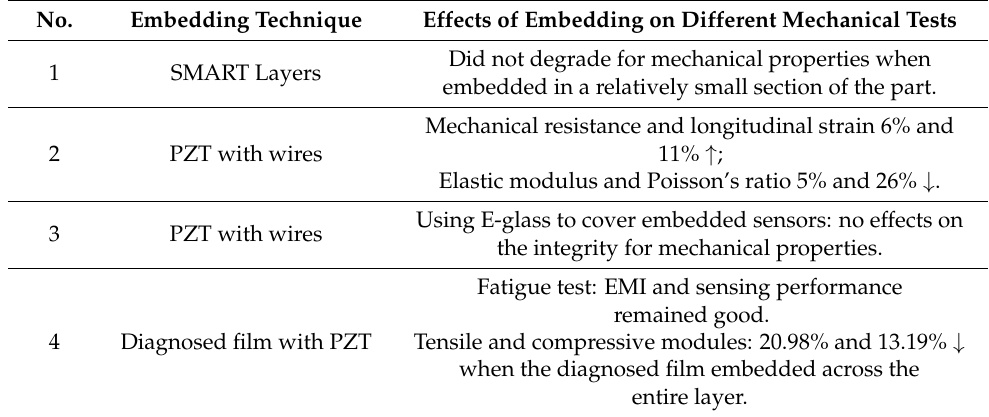
Table 1. Summary of effects of embedded PZT transducers on mechanical properties for